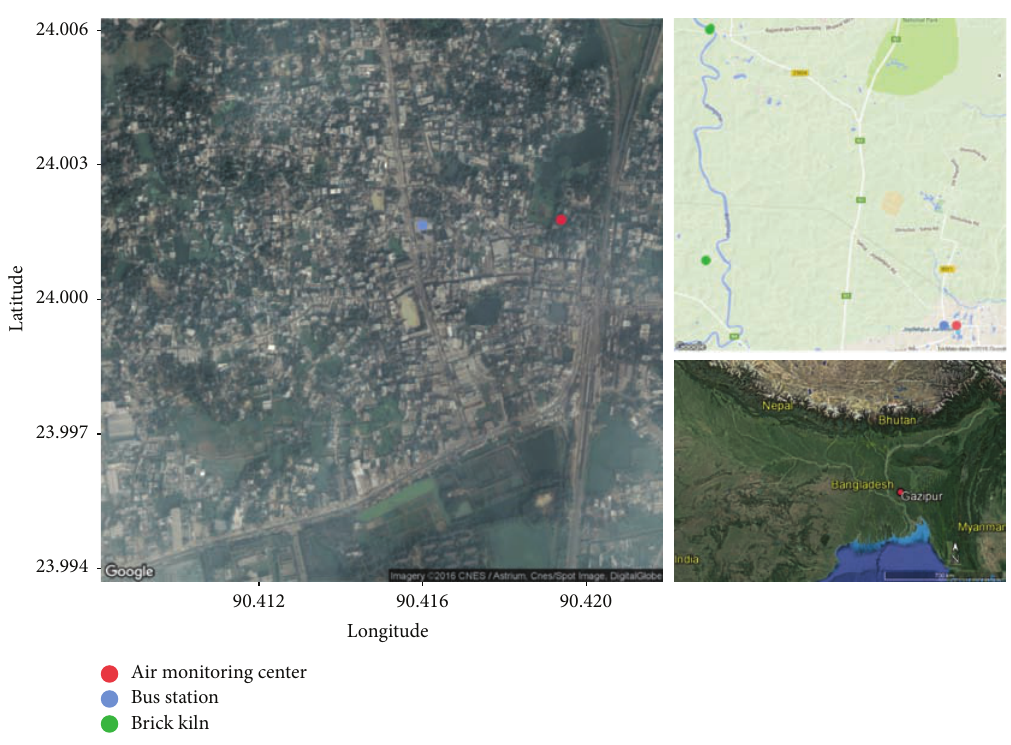
Figure 1: Location around the study area (Gazipur,